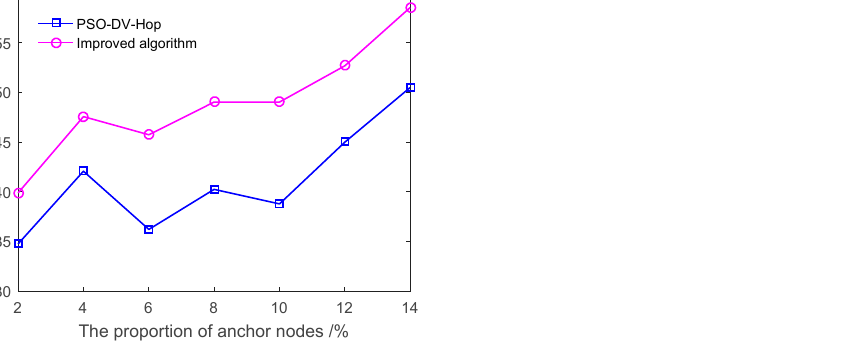
Table 2. the standard deviations of different algorithms.